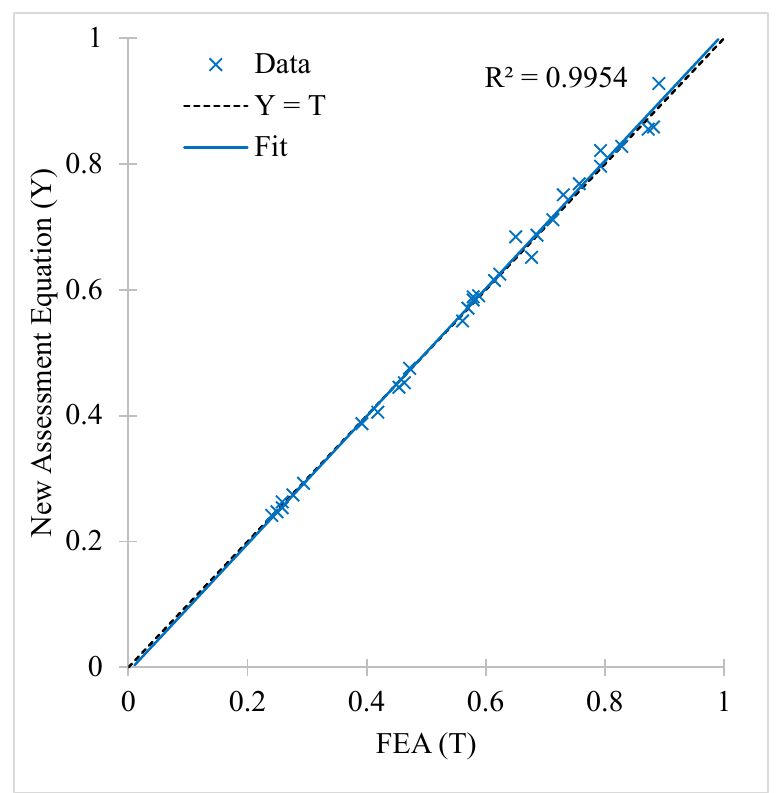
Figure 16. Regression plot of normalized failure pressure predicted by the new assessment equations against FEA results of unseen dataset.